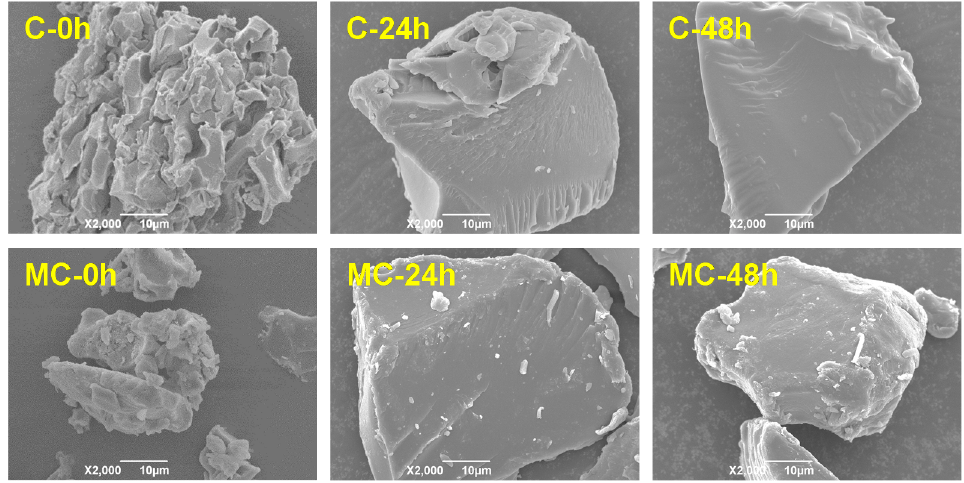
Figure 1. SEM images of conventionally (C) and microwave-cooked (MC) starches with different storage times (0, 24, or 48 h).